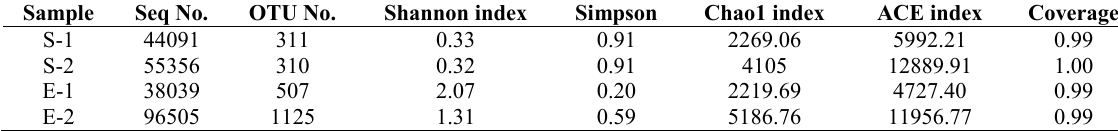
Table 2. Symbiodinium Alpha diversity index